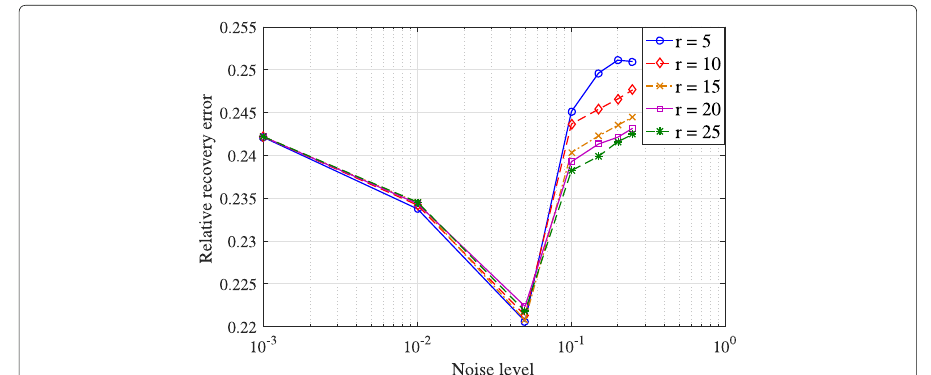
Fig. 9 Relative recovery error when the estimated noise level and rank